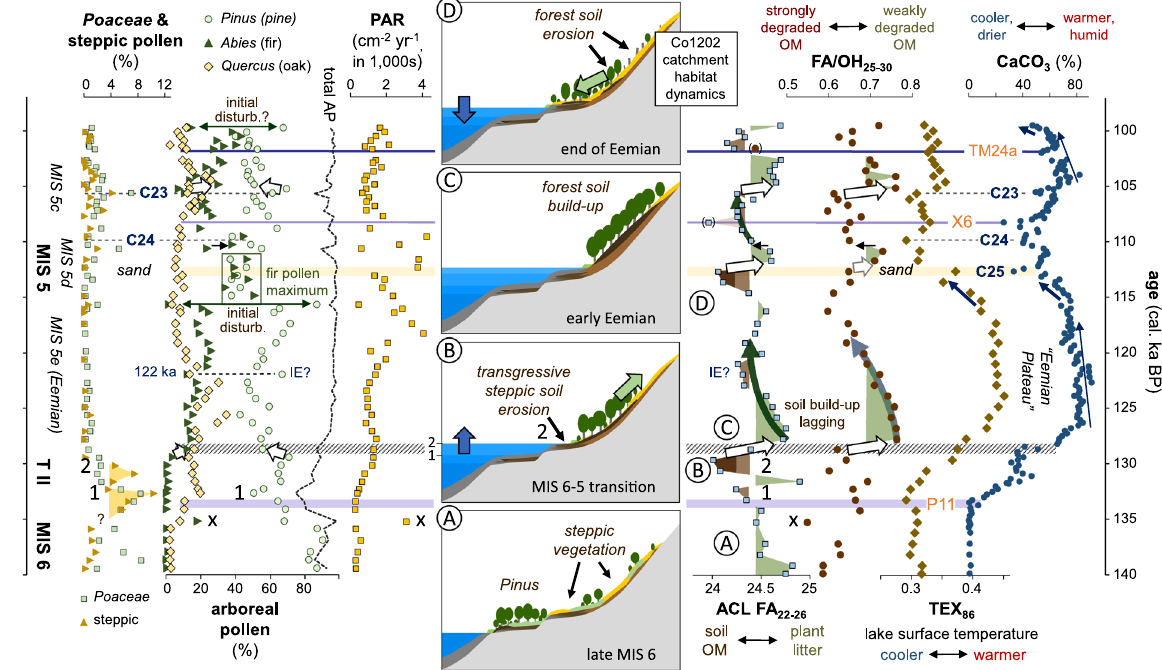
Figure 2. Records of palynological and organic geochemical data from site Co1202 (Ohrid Bay) from 140 to 99 thousand calendar years before present (cal. ka BP; BP = 1950) and schematic model of lake-level and habitat dynamics across the aridity-humidity cycle from ~137 to ~112 ka (insets A – D ). Quercus spp. includes deciduous and evergreen species, with the latter typically accounting for less than 5% of the total Quercus pollen. Slightly elevated evergreen proportions ( > 10%, max. 19%) occur between 115 and 111 ka; PAR = pollen accumulation rate (grains cm − 2 yr − 1 ). CaCO 3 data has been published previously 13 . Blue horizontal lines labelled P11, X6 and TM24a represent tephra layers used to establish the age model of Co1202 13, 38 ; MIS = marine isotope stage, T II = Termination II (MIS 6–5 transition), C23–25 = North Atlantic cold events 23–25 corresponding to the Central European Montaigu, Melisey 1 and Woillard events (see text for references), IE = Intra-Eemian cold event; white arrows mark abrupt shifts in OM quality that represent the reduction of the soil OM pool relative to standing vegetation through terrace drowning or exposure and related vegetation changes; numbers 1 and 2 label the two phases of transgression across the terrace systems in Ohrid Bay and associated soil erosion (brown minima in ACL FA 22–26 ), reducing the extent of pine habitat (phase 1) and delivering steppic pollen from the preceding vegetation cover (phase 2, maximum in steppic pollen; inset B